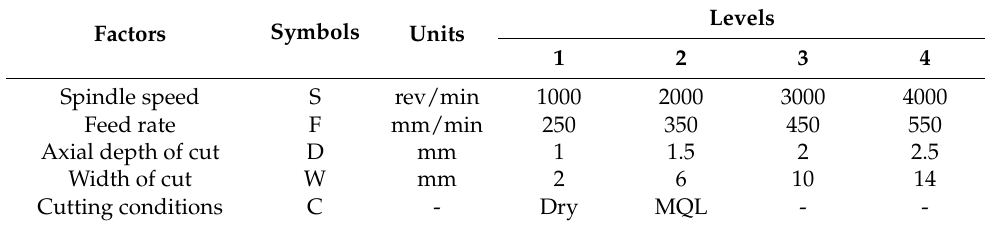
Figure 2. The average values of readings are depicted in Table 4.